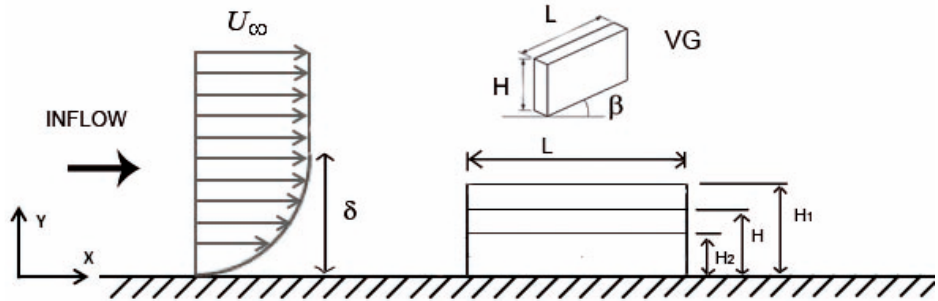
Figure 1. Sketch of the vortex generator (VG) dimensions with respect to the local boundary layer (not to scale).